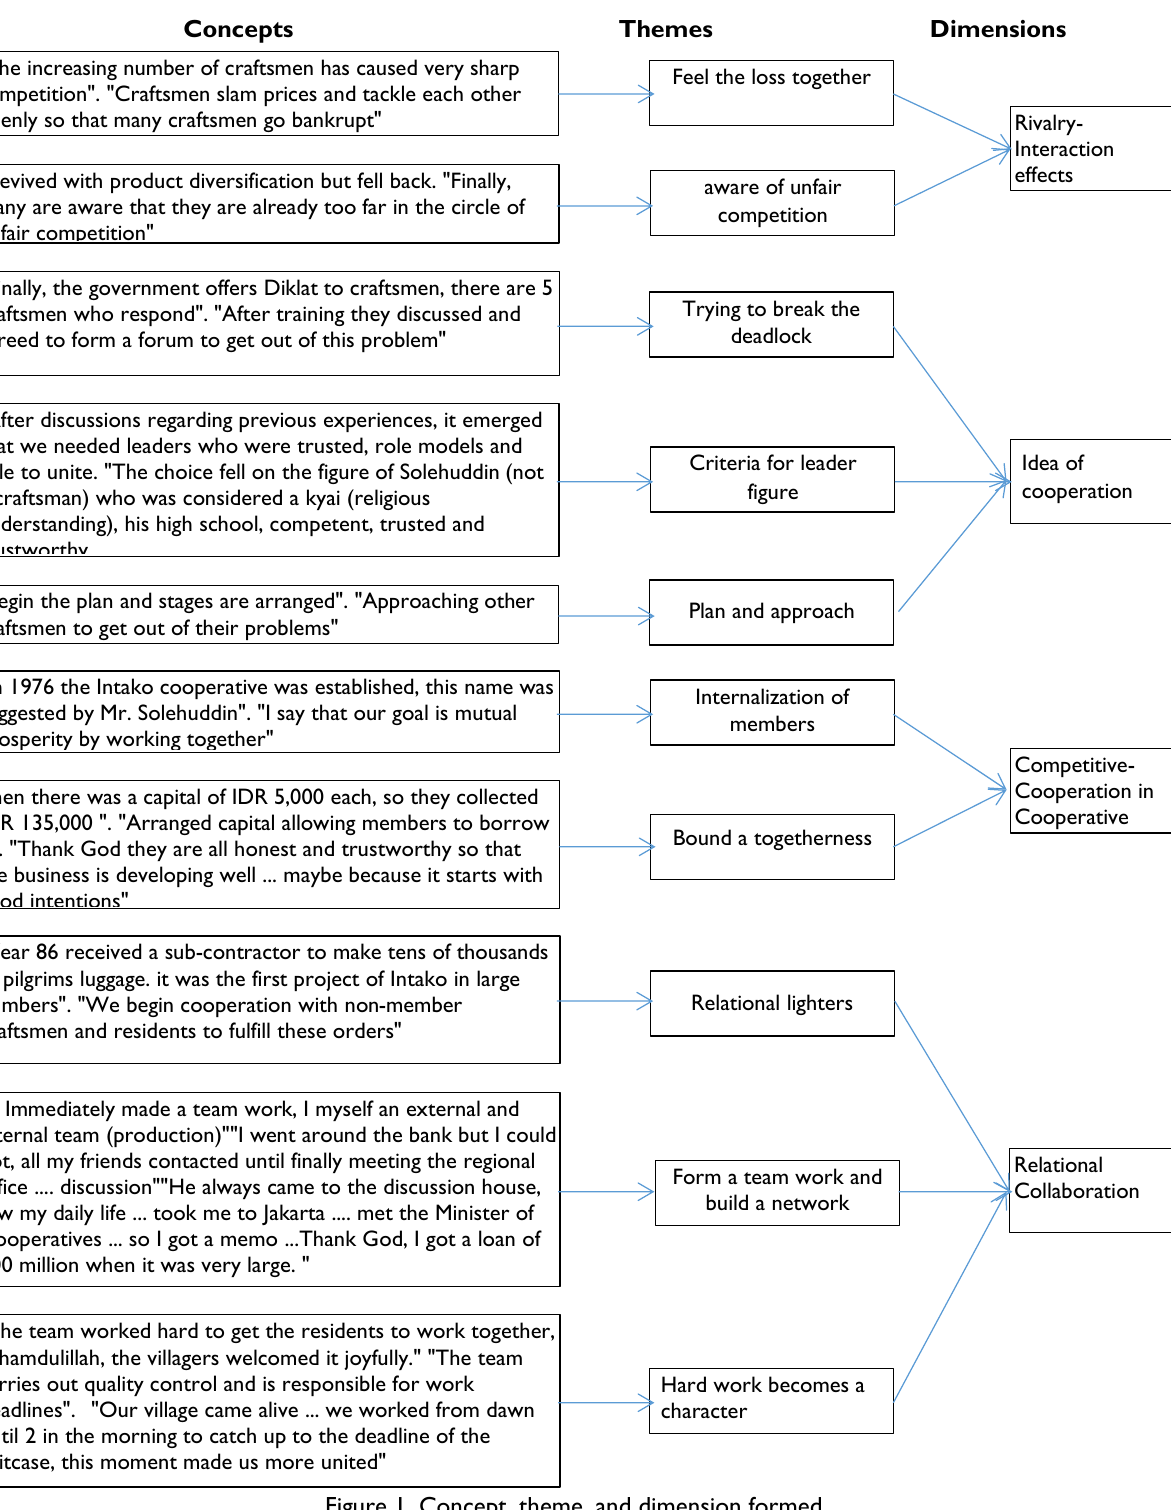
Figure 1. Concept, theme, and dimension